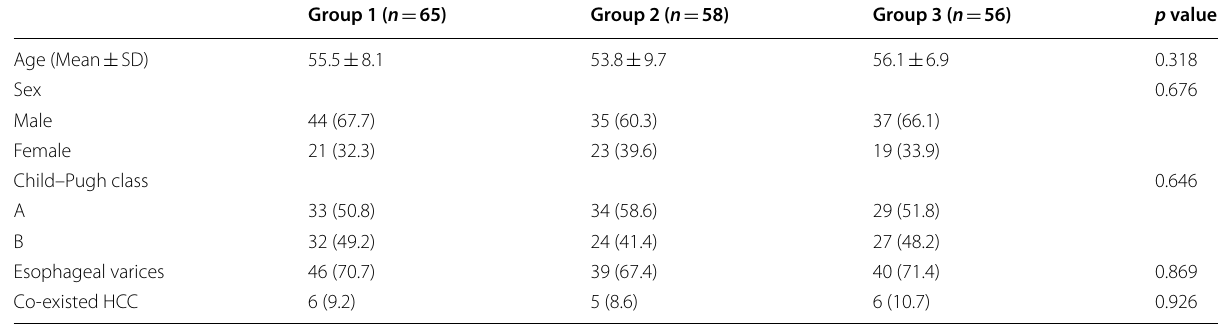
Unless otherwise indicated, data represent the number of patients and percentage in parenthesis Group 1—Gelfoam group, Group 2—Embosphere microspheres group, Group 3—polyvinyl